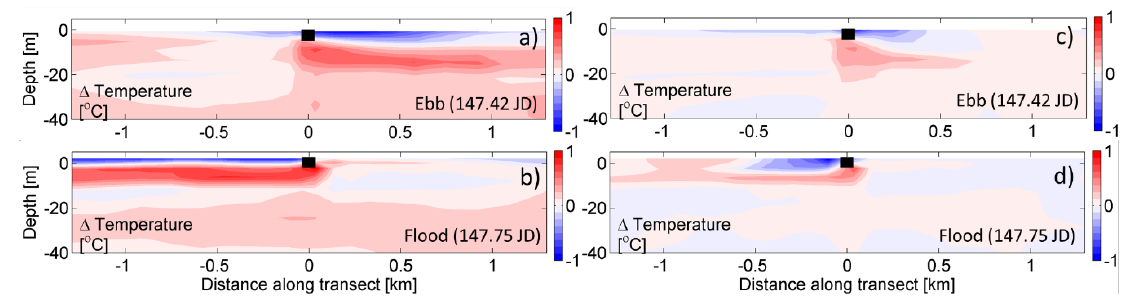
Figure 20. ( a , b ) Temperature difference of baseline scenario with HCB relative to test 1 without HCB during peak ebb and flood; ( c , d ) velocity difference of baseline scenario with HCB relative to test 2 with draw span open during ebb and flood. (Typical spring tide on 27 April 2017).